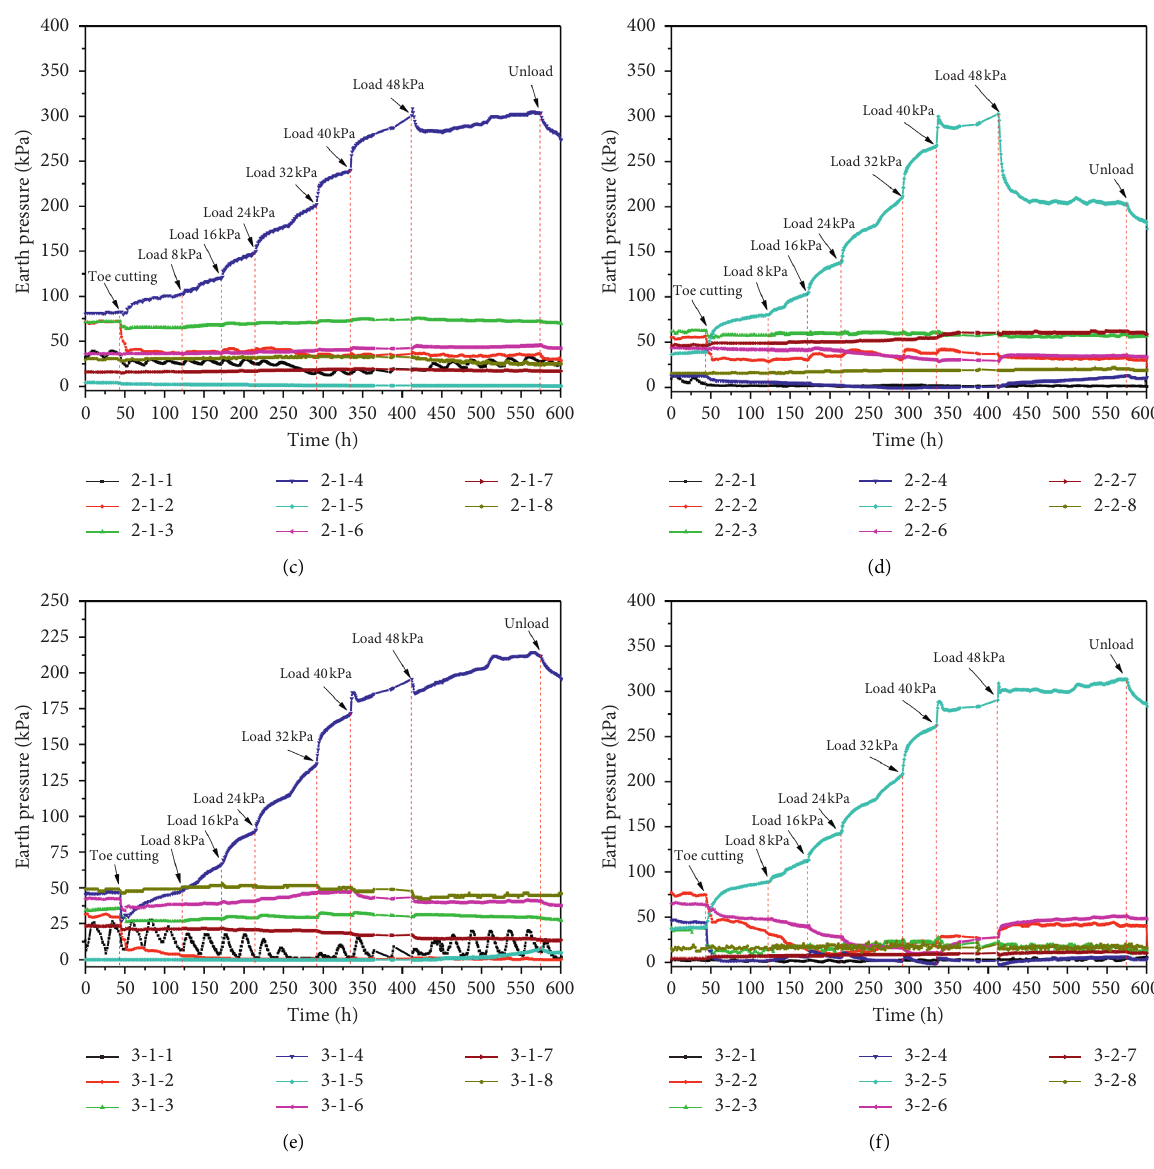
Figure 10: Earth pressure of micropiles. (a) Curves of earth pressure at measuring points before the pile in first row; (b) curves of earth pressure at measuring points behind the pile in first row; (c) curves of earth pressure at measuring points before the pile in middle row; (d) curves of earth pressure at measuring points behind the pile in middle row; (e) curves of earth pressure at measuring points before the pile in last row; (f) curves of earth pressure at measuring points behind the pile in last